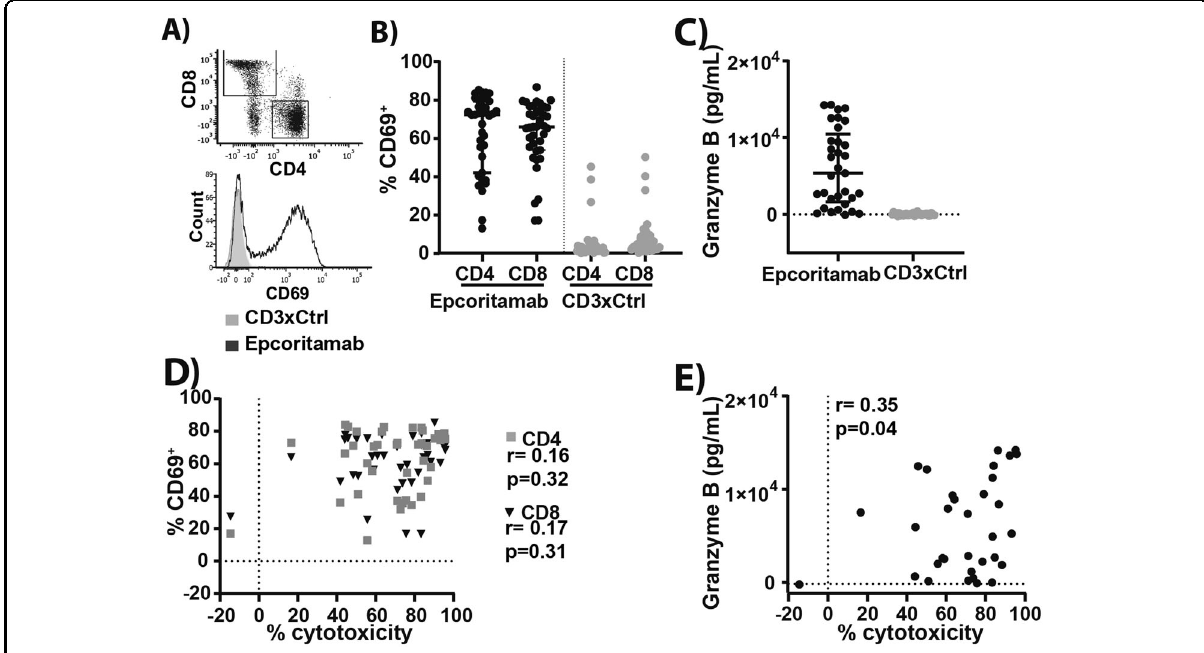
Fig. 2 T-cell activation by epcoritamab does not correlate strongly with cytotoxic activity. A Gating of CD4 + and CD8 + cells and example of a fl ow histogram for CD69 positivity and B percentages of CD69-positive CD4 + and CD8 + allogeneic T-cells after treatment of B-NHL samples with epcoritamab and CD3xCtrl (30 ng/mL) (median ± interquartile range). C Granzyme B levels (pg/mL) in supernatants of coculture of B-NHL sample and allogeneic T-cells stimulated with epcoritamab and CD3xCtrl (30 ng/mL) (median ± interquartile range). D , E Correlation between percentage CD69- positive (CD4 + and CD8 + ) allogeneic T-cells ( D ) or granzyme B release (pg/mL) ( E ), and cytotoxicity induced by epcoritamab (30 ng/mL) (Spearman ’ s; ns and r = 0.35; * p = 0.04, respectively). All samples from different B-NHL subtypes and from ND and RR are plotted